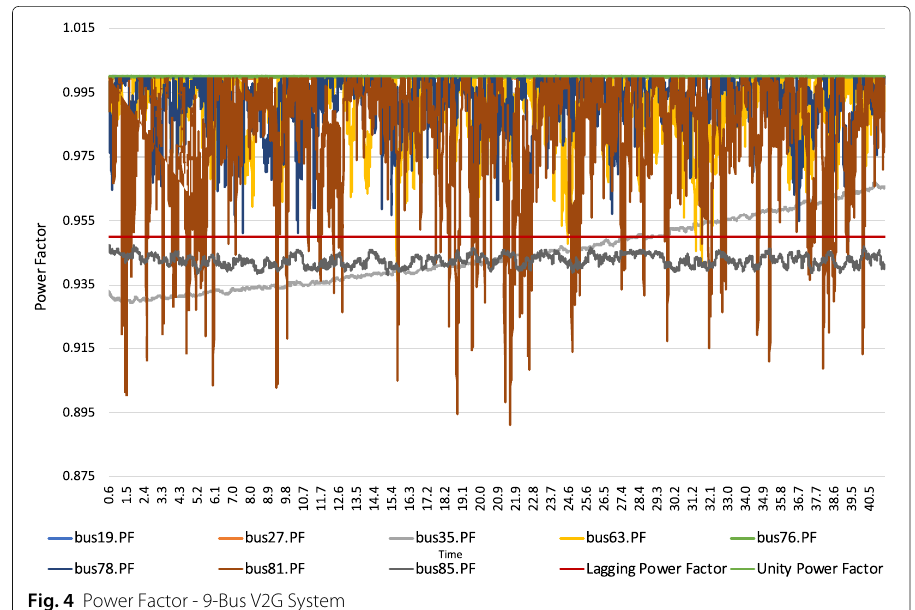
Fig. 4 Power Factor - 9-Bus V2G